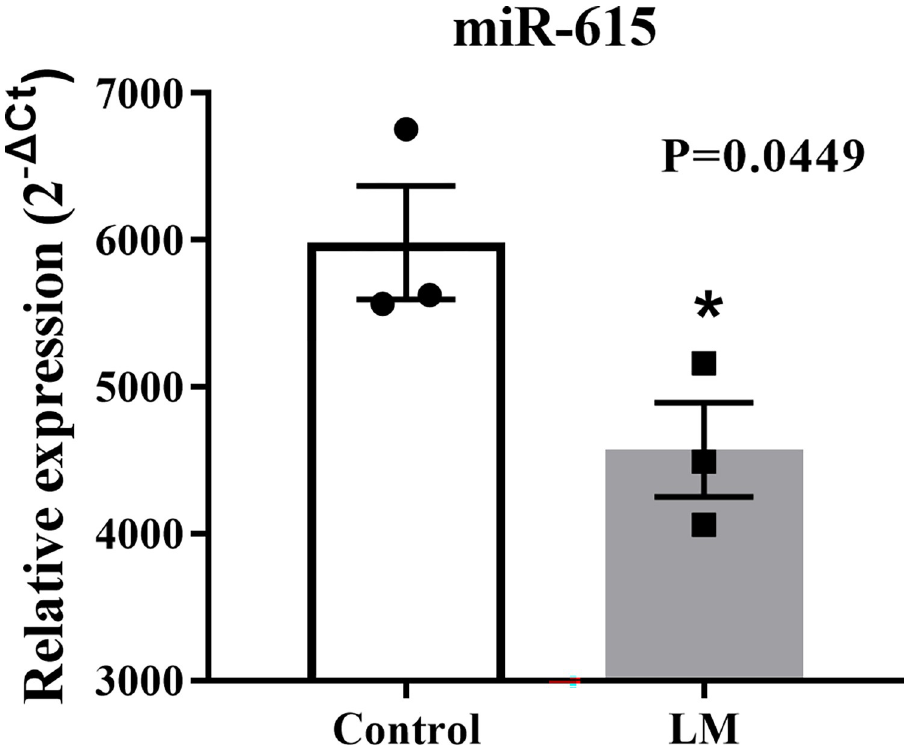
Fig 8. Bta-miR-615 analysis in blastocysts. Bta-miR-615 relative expression miRNA in blastocysts cultured conventionally (control) or in LM system. Statistics was performed using Student’s t test. Asterisk means statistical difference (P < 0.05). Standard bars represents the